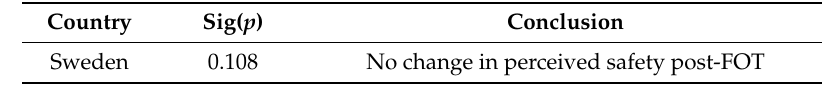
Table 5. Green Driving Support: Wilcoxon test for differences in pre-/post-FOT responses.